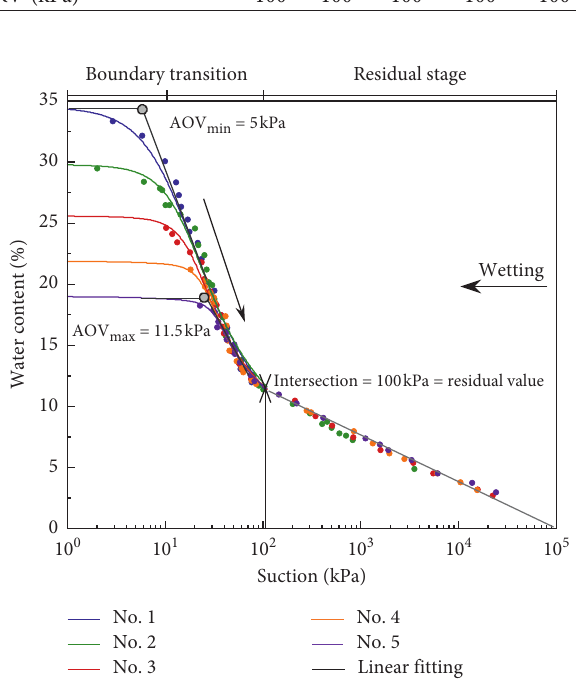
Figure 7: Test data and fitting curves of five specimens using piecewise fitting.